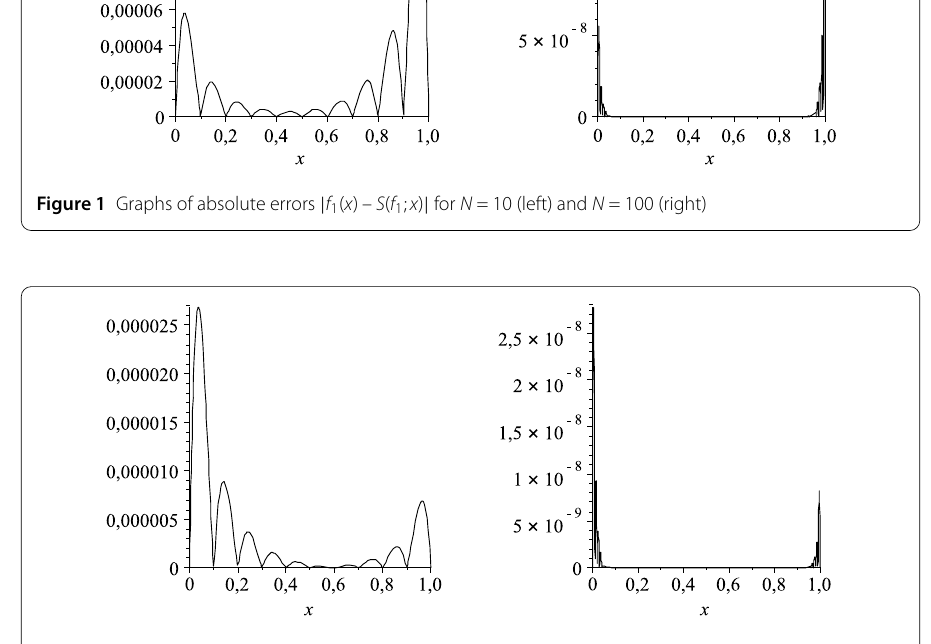
Figure 2 Graphs of absolute errors | f 2 ( x ) – S ( f 2 ; x ) | for N = 10 (left) and N = 100 (right)